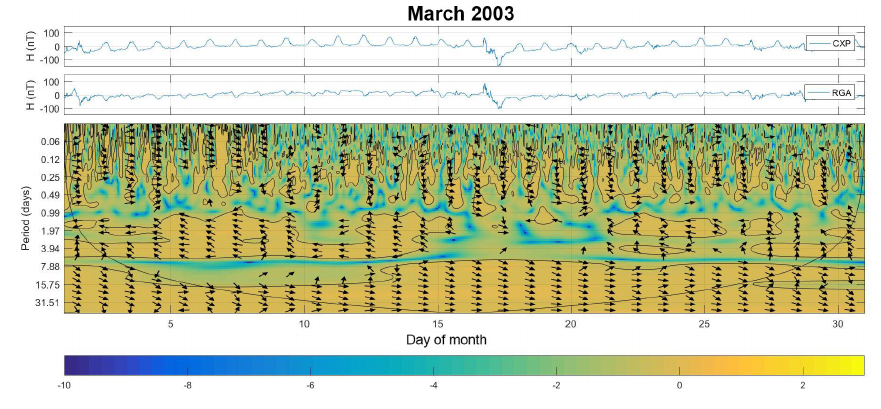
Figure 7. The same as Fig. 4 but for CXP and RGA.